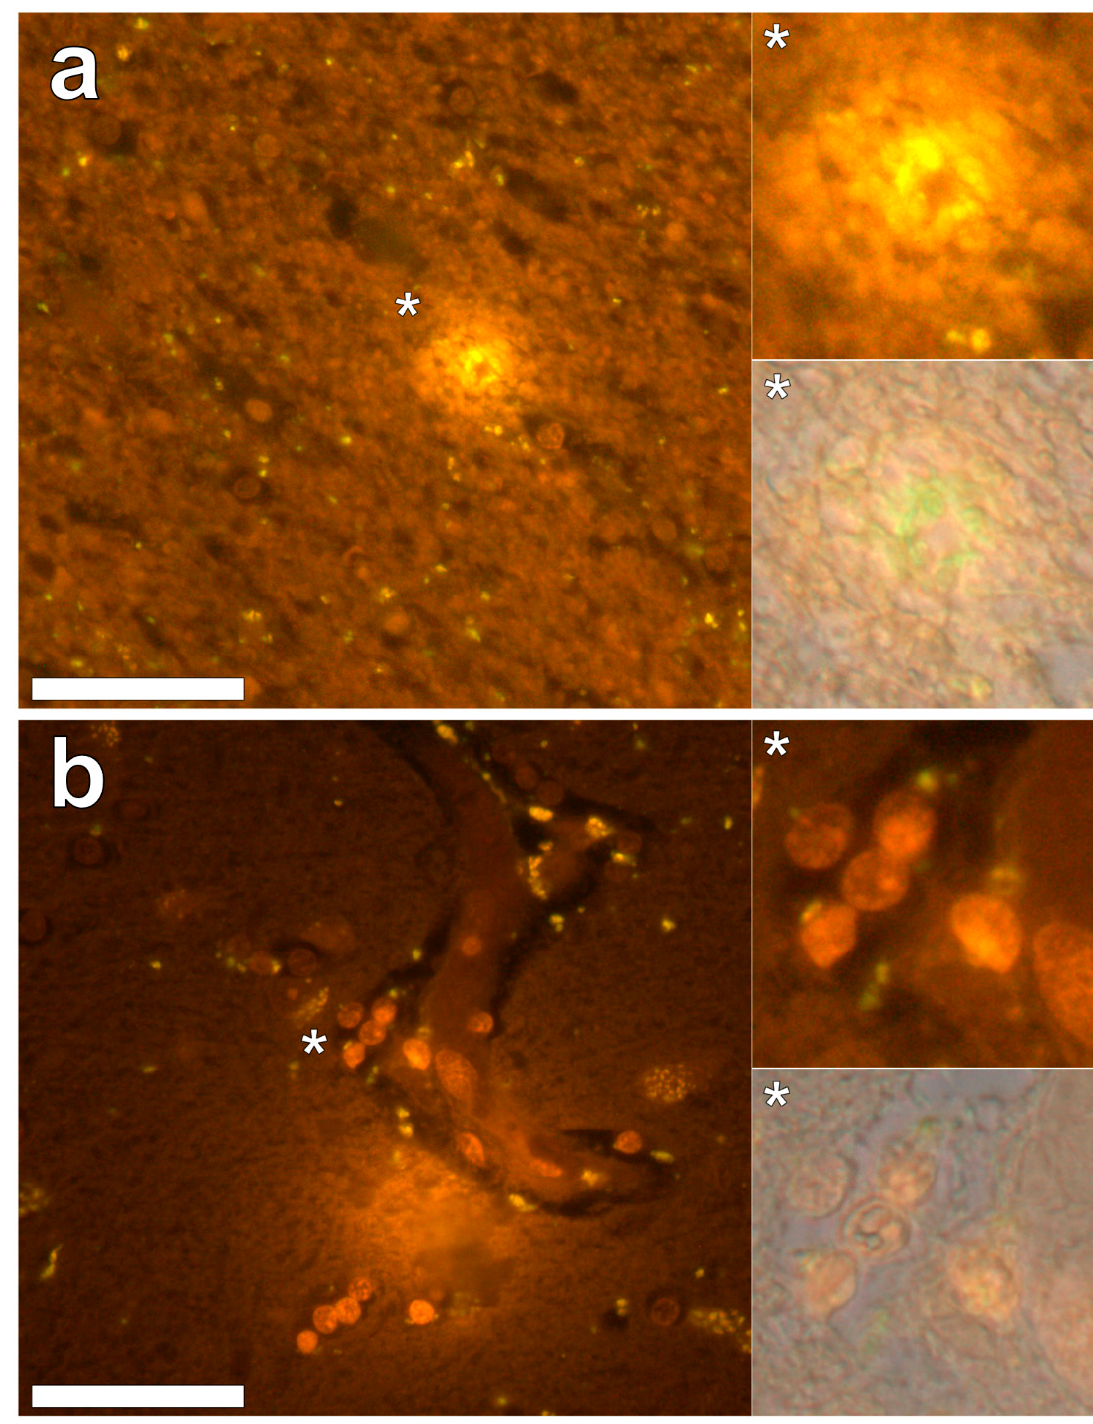
Figure 3. Extracellular aluminium highlighted via an intense orange fluorescence emission in the white matter of the temporal lobe ( a ). Intracellular aluminium was also noted in the temporal cortex ( b ) as highlighted via punctate orange fluorescence within inflammatory cells in the vessel wall. Magnified inserts and their bright field overlays are denoted by asterisks. Magnification × 400, scale bars: 50 µm.